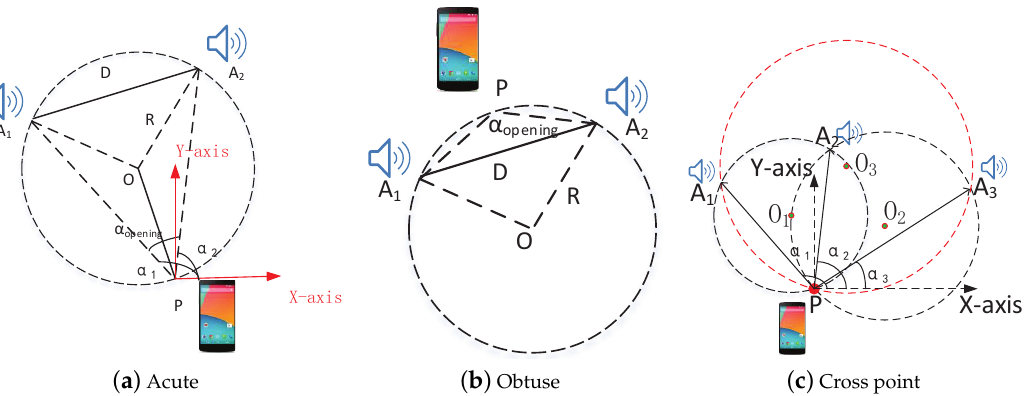
Figure 8. Location estimation: ( a ) α opening is acute; ( b ) α opening is obtuse; and ( c ) chosen location lies on the crossing of three circumcircles O 1 , O 2 , and O 3 to be the phone’s location. α 1 , α 2 and α 3 represent the AoA estimations, which are relative to the